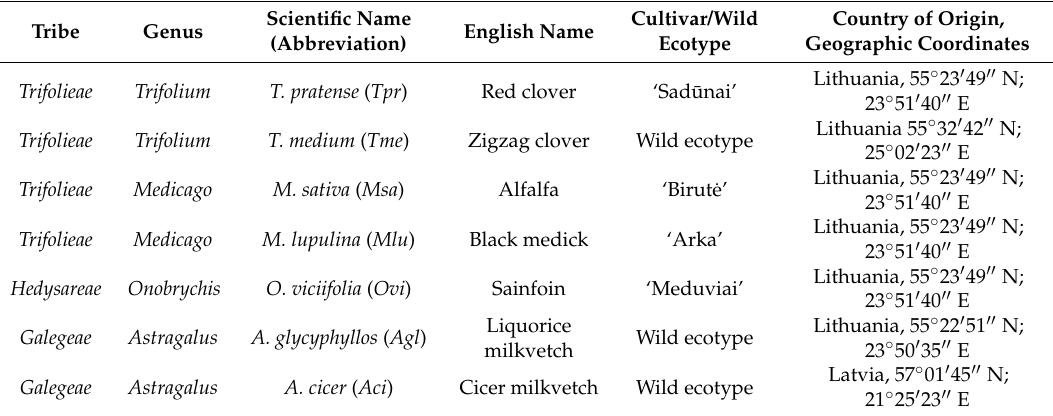
Table 5. A list of the studied perennial legume species from the sub-family Faboideae